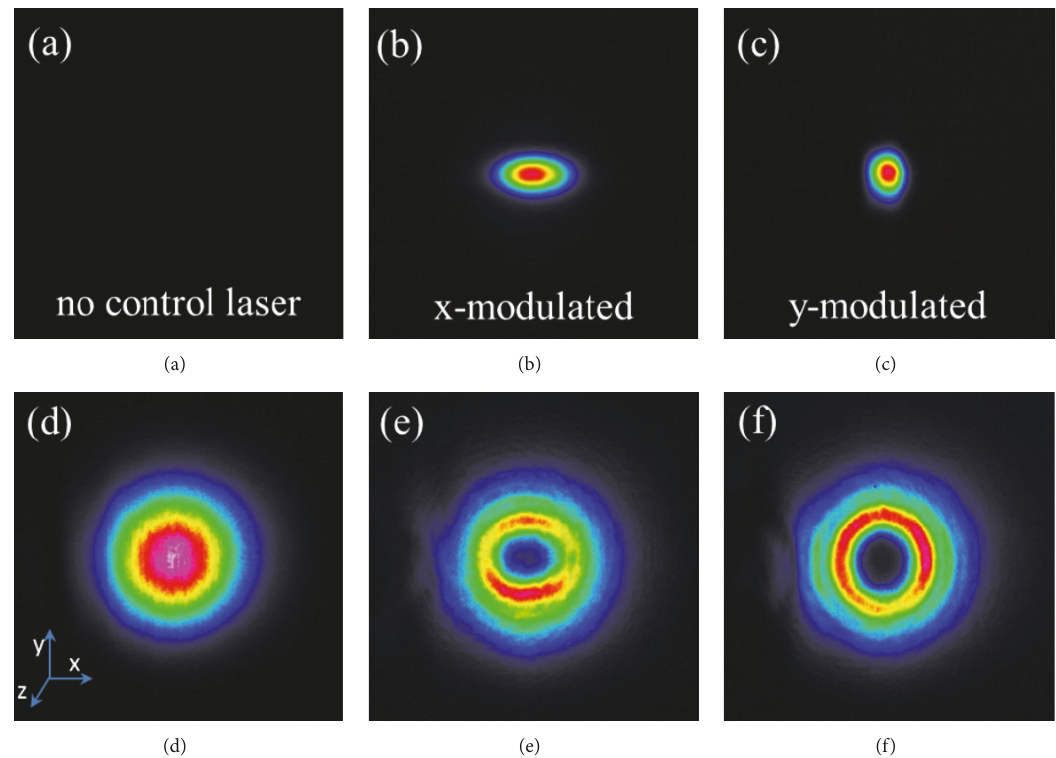
Figure 5: (b)-(c) Intensity distribution of control light with x-modulated and y-modulated. (d)–(f) Intensity profile of signal light under the condition of no control laser, x-modulated, and y-modulated control light.